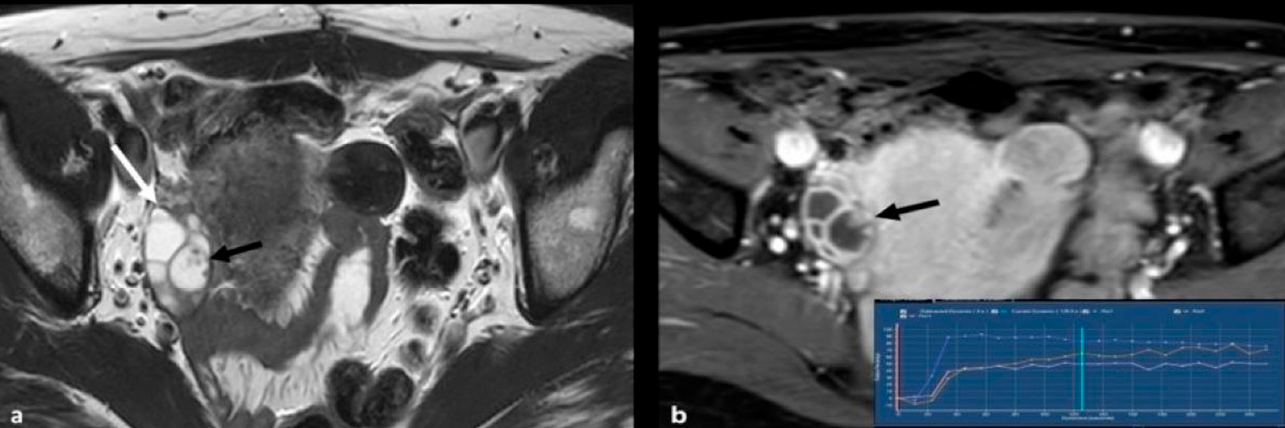
Figure 4. Low grade serous cystadenocarcinoma. Axial T2 weighted image ( a ) shows a multiloculated, predominantly cystic mass at the left ovary (white arrows) with solid tissue (asterisks) showing avid enhancement on the T1 weighted FS CE image (( b ), white arrows).